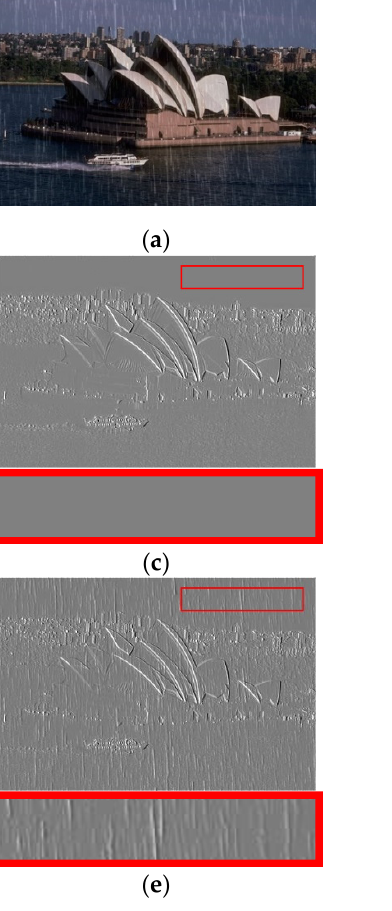
Figure 1. ( a , b ) are the rainy image and rainless image, respectively. ( c , d ) are the gradient maps of the rainless image along the x and y directions, respectively. ( e , f ) are the gradient maps of corresponding rainy image along the x and y directions, respectively.